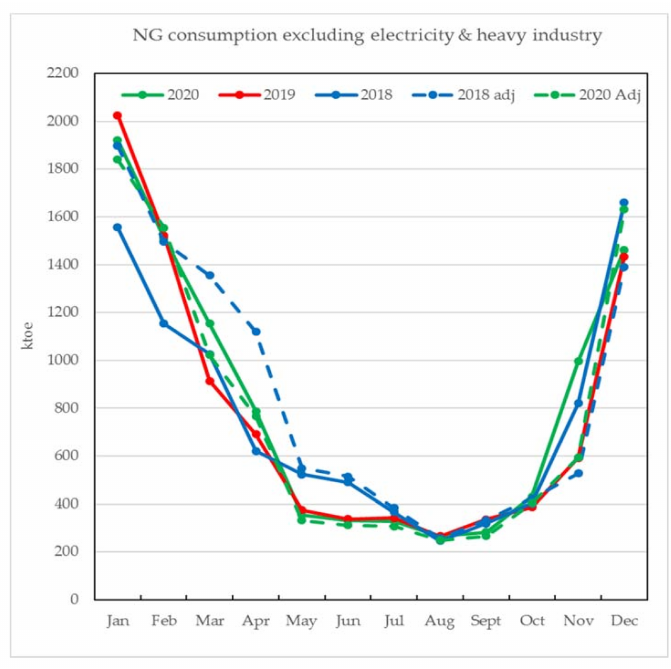
Figure 8. Monthly amounts of NG consumption excluding those for electricity production and heavy industry (in